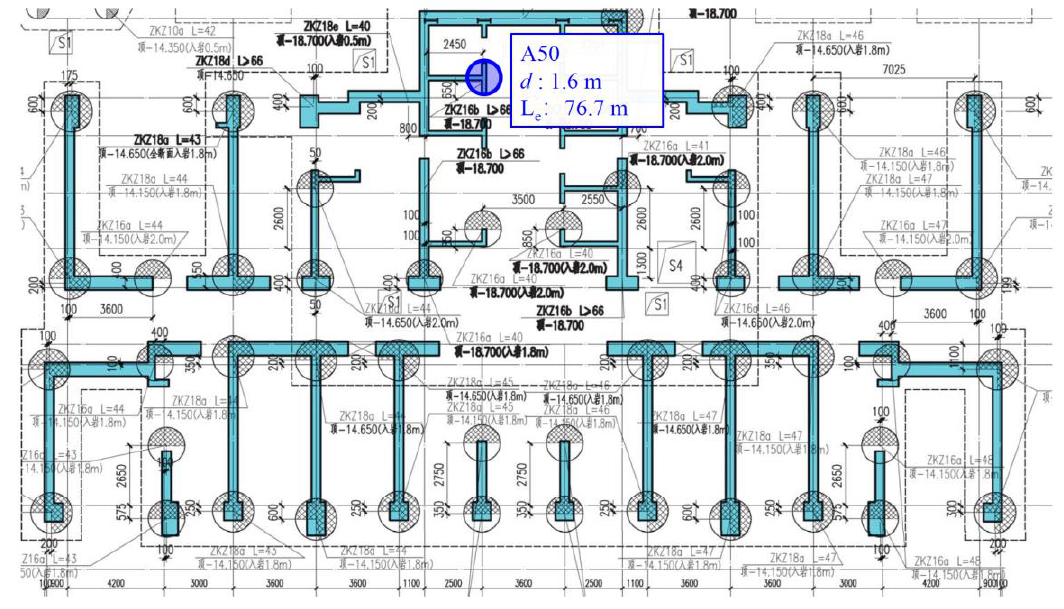
Figure 3. The location of Pile A50.